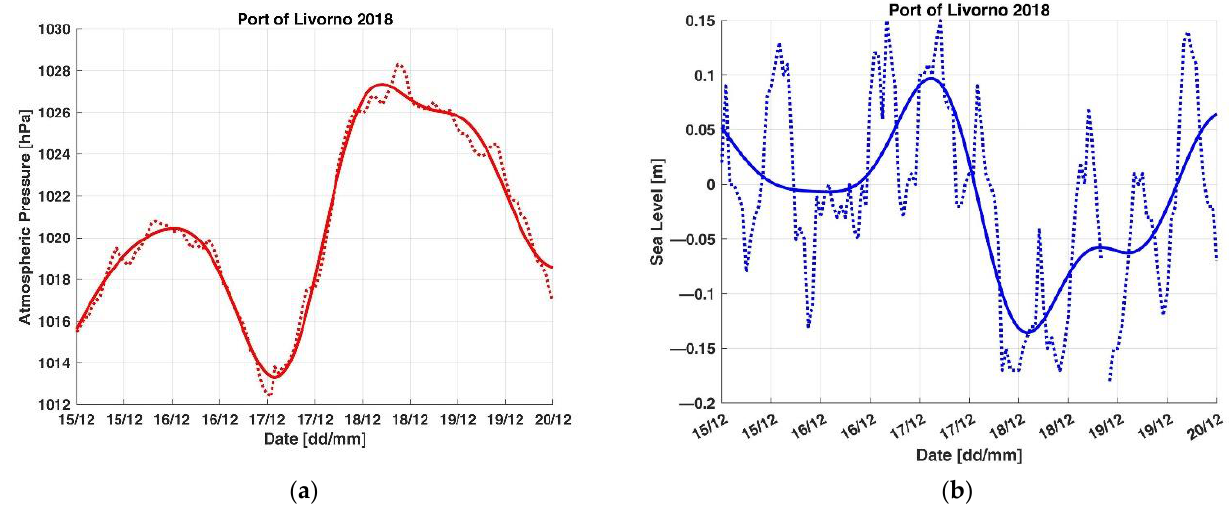
Figure A9. Low-frequency components of meteo-mareographic parameters acquired by ISPRA’s monitoring station in the port of Livorno from 15 to 20 December 2018 (some missing sea level data on 18 December have been reconstructed by means of interpolation before low-pass filtering): ( a ) atmospheric pressure; ( b ) sea level.